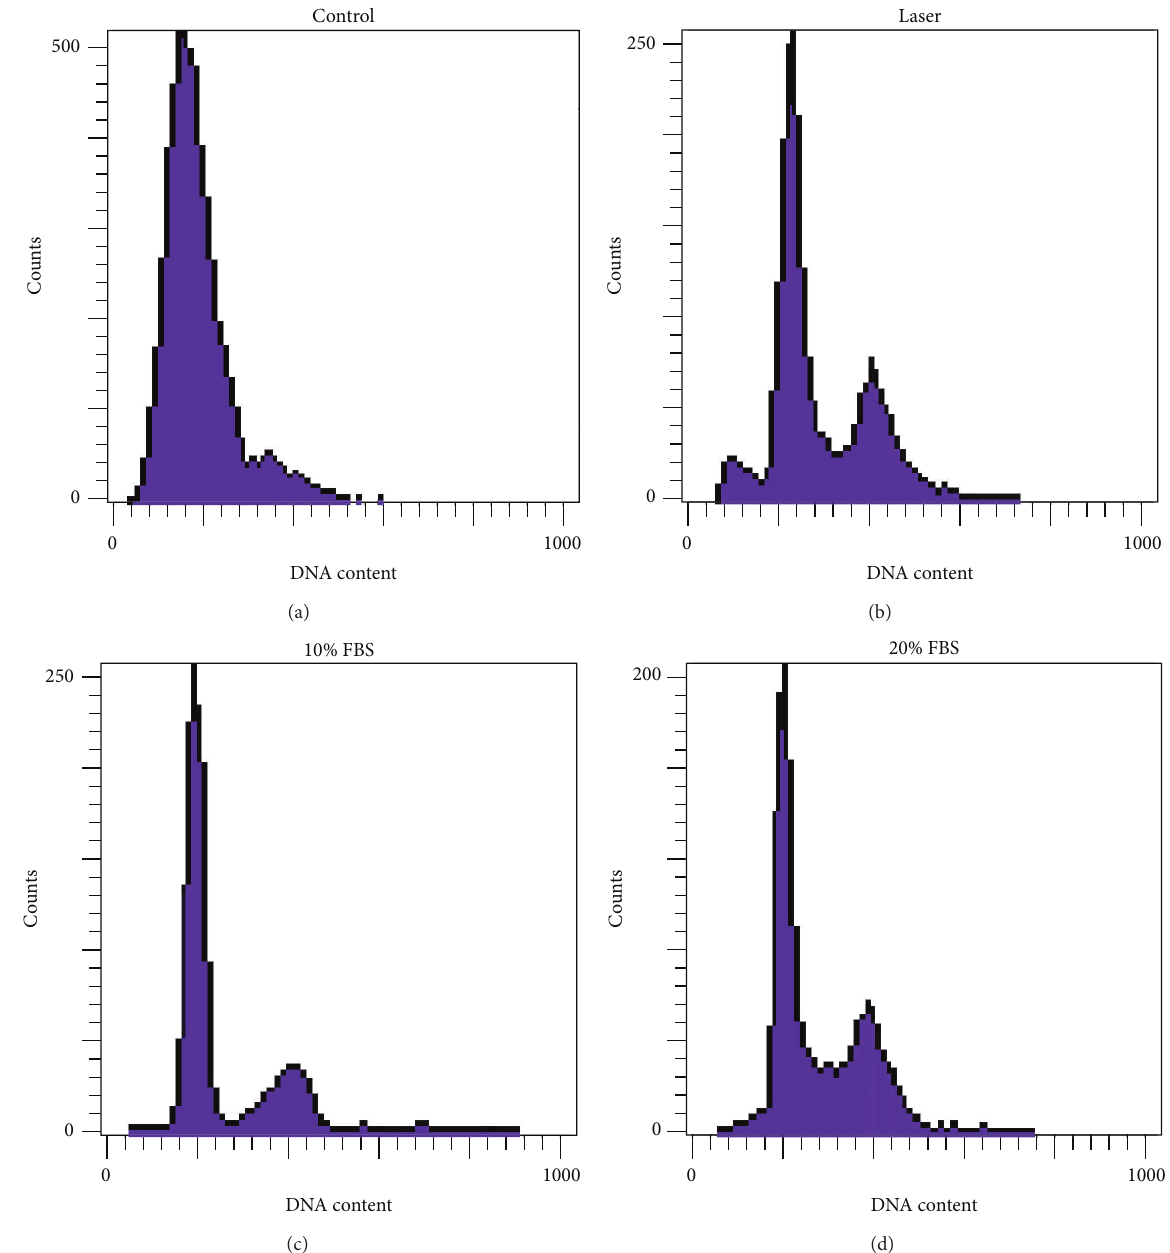
Figure 2: Effects of LLLI on the proliferation index of myoblasts 24 h after irradiation/refeeding. Typical flow cytometric DNA histograms of the myoblasts from control (a), laser irradiation (b), 10% FBS (c), and 20% FBS (d) groups,